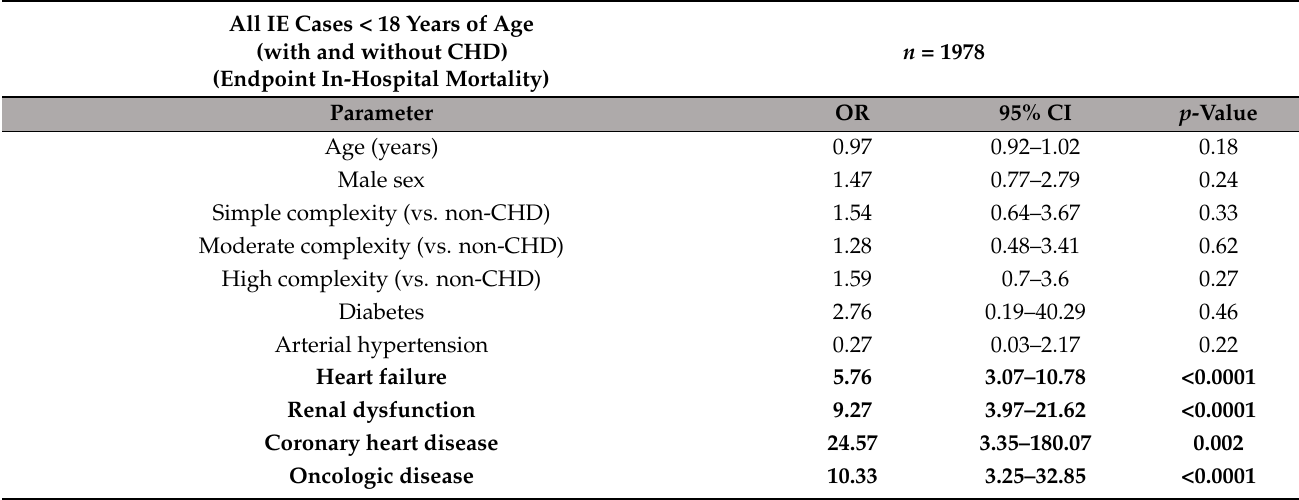
Table 4. Association between age, sex, disease complexity and co-morbidities, and death in all paediatric patients with infective endocarditis. IE = infective endocarditis; CHD = congenital heart disease; CI = confidence interval; OR = odds ratio. Significant variables are in bold.